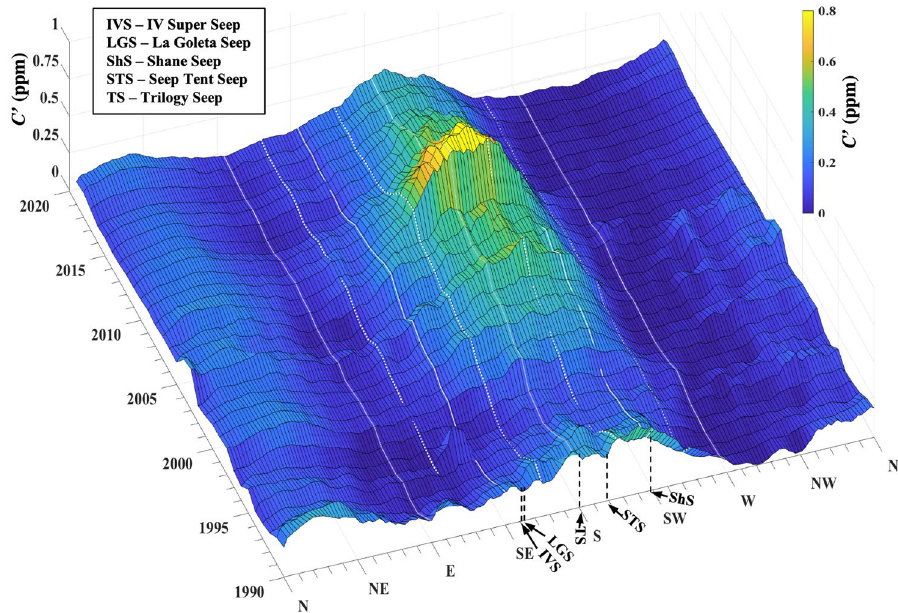
Figure 5. Average annualized concentration anomaly, C ′ ( t , θ) , versus wind direction, θ , and time. Named seeps’ θ shown (see Supplementary Table S1); see legend for codes. See Supplementary Fig. S4B for overhead view of C ( t , θ) . Supplementary Fig. S4A shows an overhead view of u ( t , θ) .